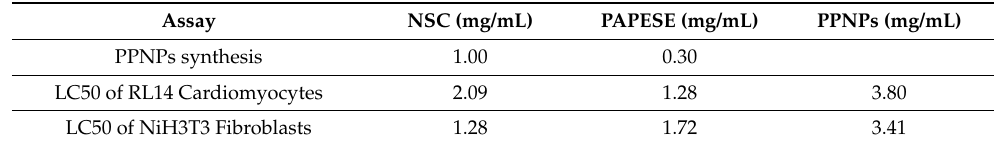
Table 2. Lethal concentration 50 for RL14 human cardiomyocytes and NiH3T3 murine fibroblasts exposed to PPNPs and their precursors, N-succinyl chitosan (NSC) and azobenzene derivate (PAPESE).